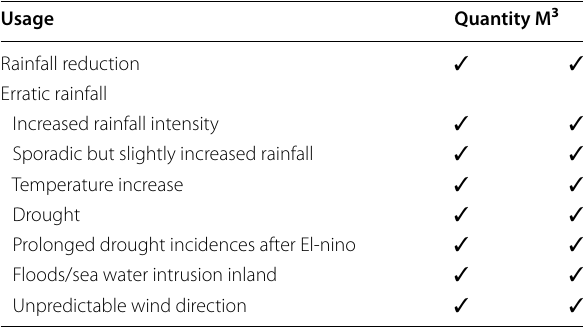
Table 1 Summary climate related impacts factors as felt